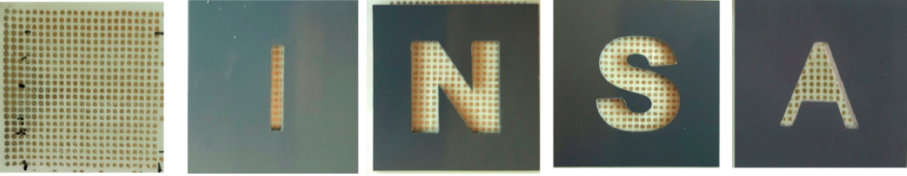
Figure 9. Photo ‐ capacitor arrays using letter ‐ shaped masks.